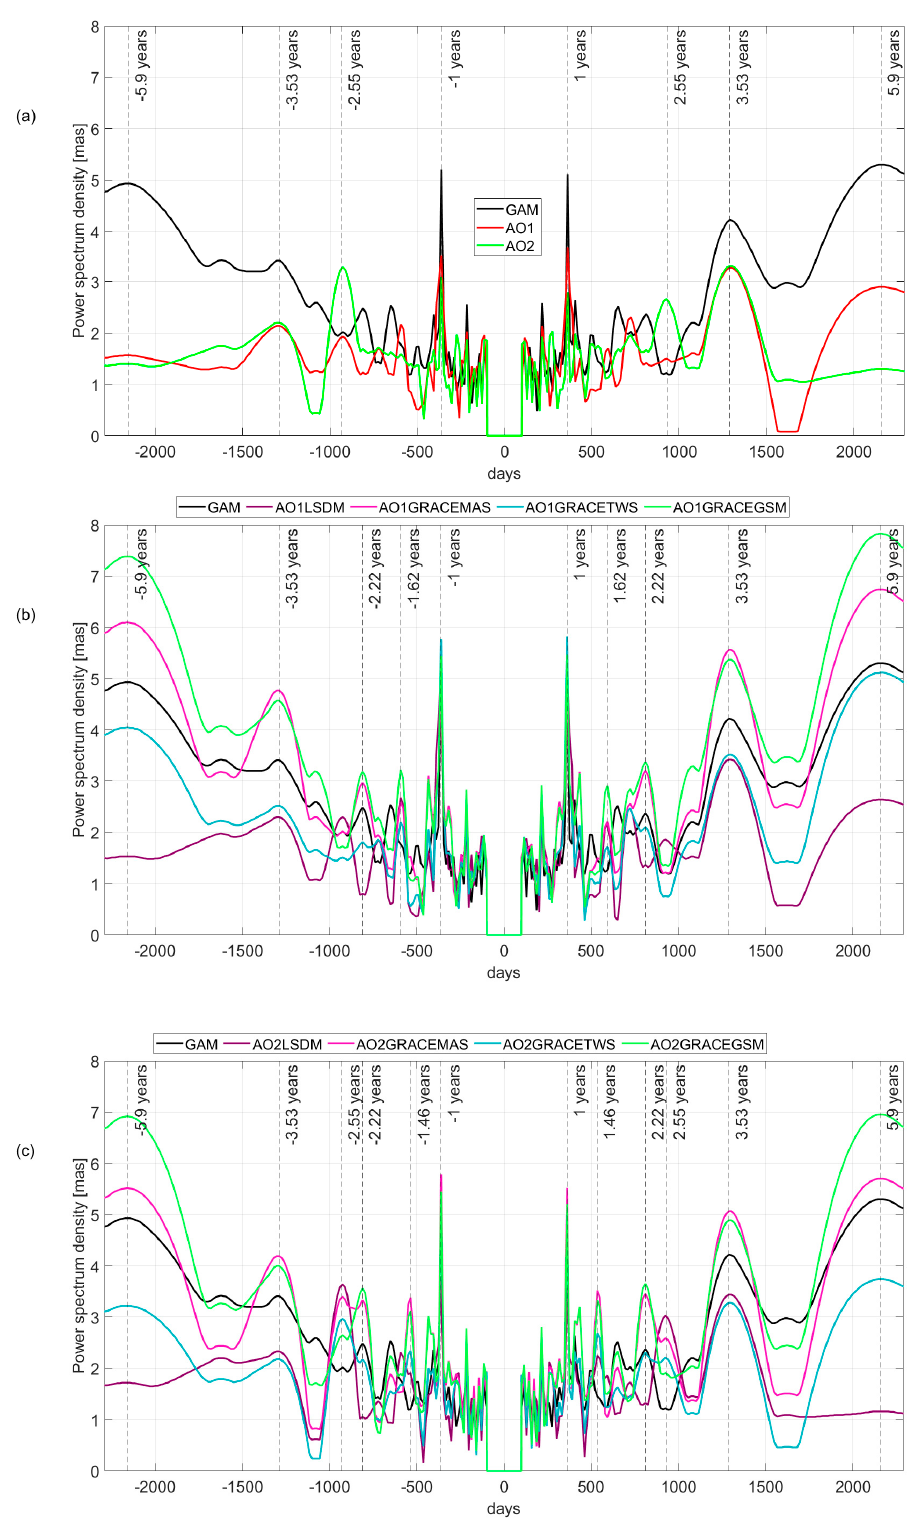
Figure 7. ( a ) Fourier Transform Band Pass Filter (FTBPF) amplitude spectra for the different complex GAM excitations and: ( a ) AO1 and AO2 geophysical excitations; ( b ) AO1 geophysical excitations improved by HAM LSDM, GRACE GSM, GRACE TWS, and MAS excitations; and ( c ) AO2 geophysical excitations improved by HAM LSDM, GRACE GSM, GRACE TWS, and MAS excitation functions.